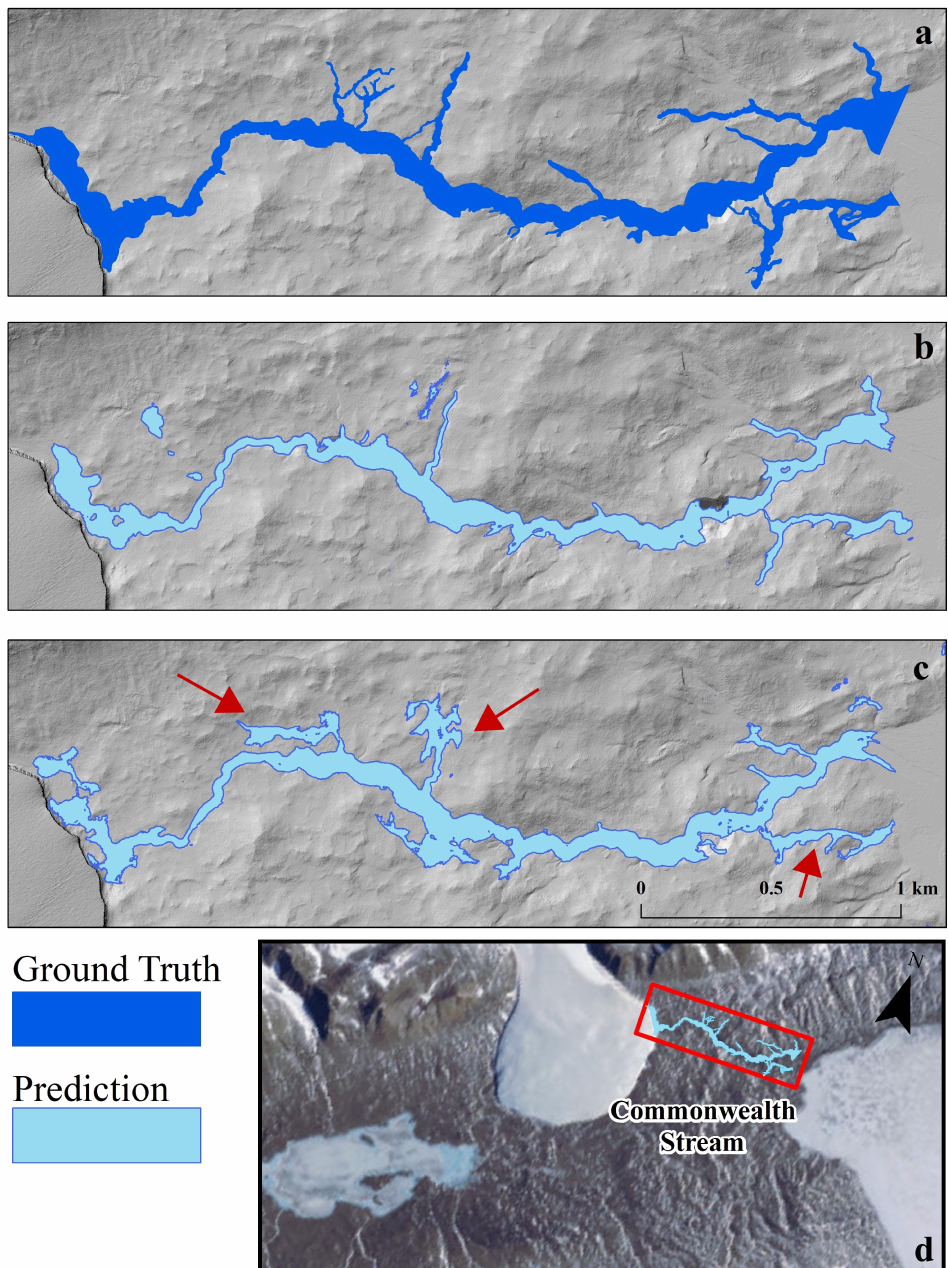
Figure 9. Ground truth and predictions on a subset of the full-valley predictions (Commonwealth Stream). ( a ) Ground truth for Commonwealth Stream ( b ) Predictions for the elevation-based model ( c ) Predictions for the slope-based model. ( d ) location map of Commonwealth Stream. Red arrows indicate the tributaries where the slope model overpredicted stream